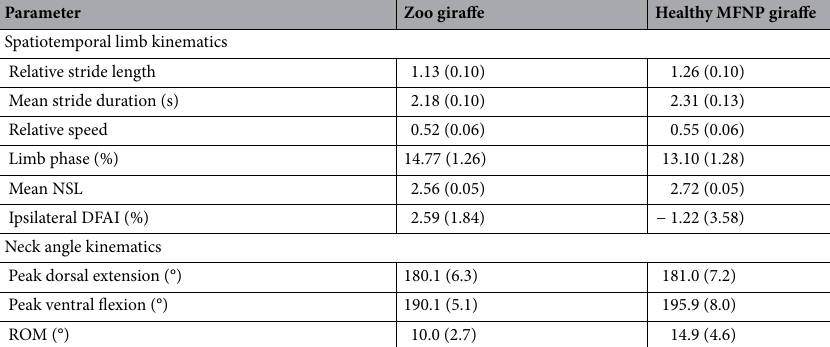
Table 2. Mean spatiotemporal limb kinematics and neck angle kinematics of four adult (n = 3 females and 1 male) Masai giraffe ( Giraffa tippelskirchi ) housed at Cleveland Metroparks Zoo (n = 31 strides for limb kinematics and n = 7 strides for neck angle kinematics) vs. those of healthy free-ranging Nubian giraffe ( Giraffa camelopardalis camelopardalis ) from Murchison Falls National Park, Uganda (n = 34 strides for limb kinematics and n = 22 strides for neck angle kinematics). Standard deviations are listed in